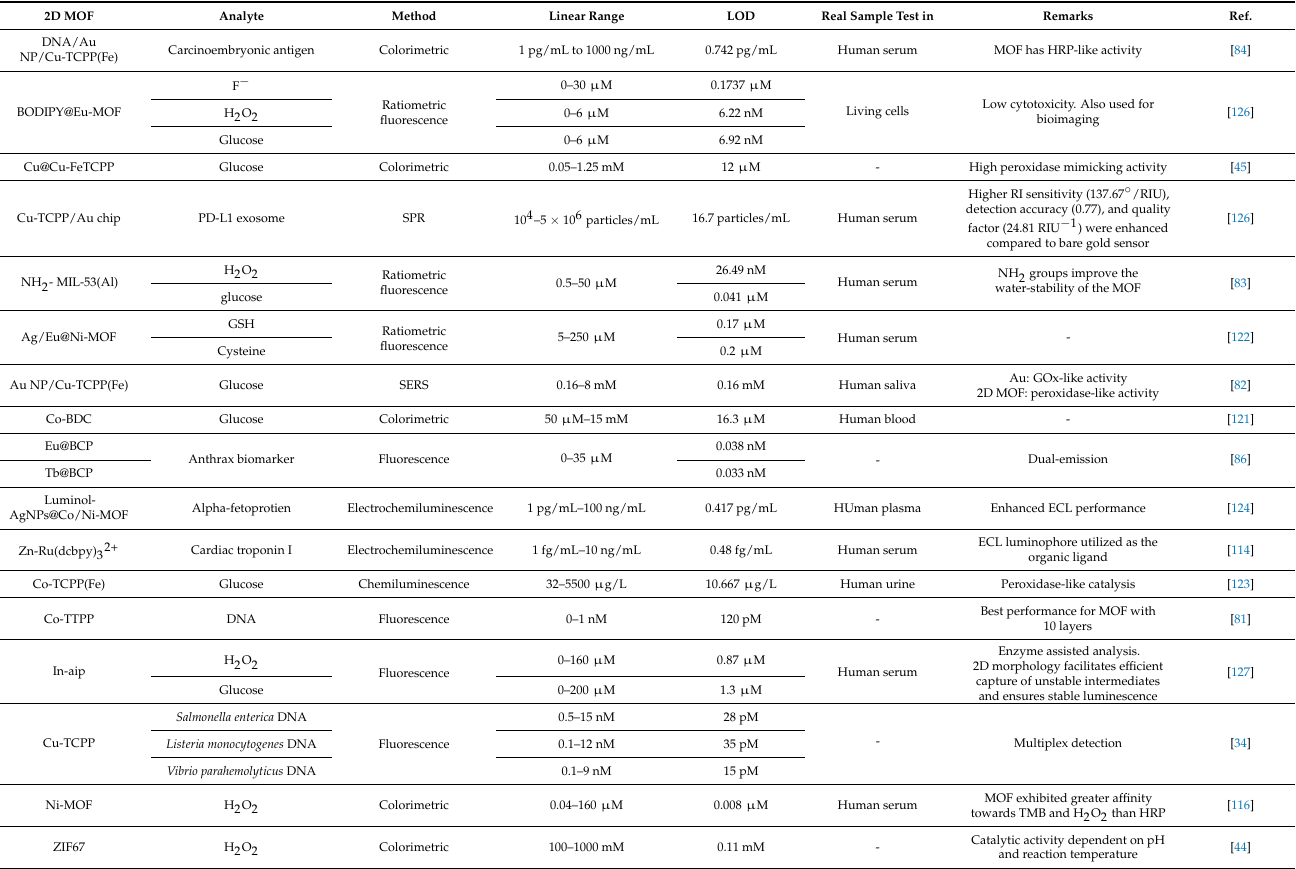
Table 4. Summary of 2D-MOF based optical